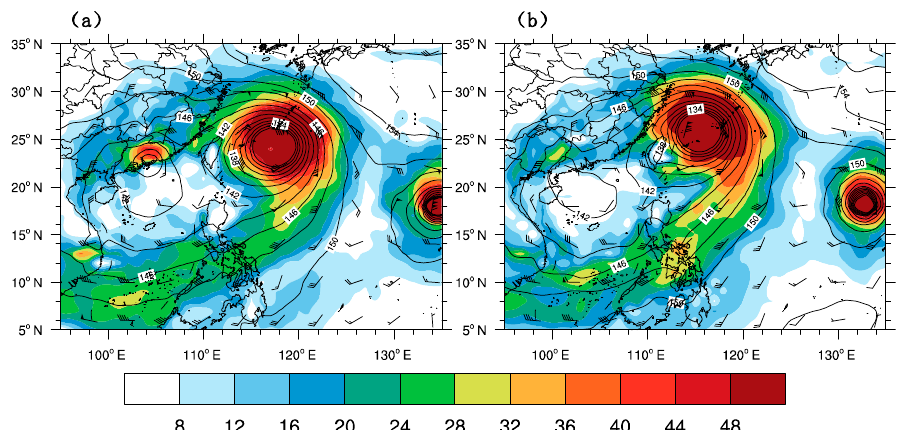
Figure 1. Model domain and best track of the typhoon.